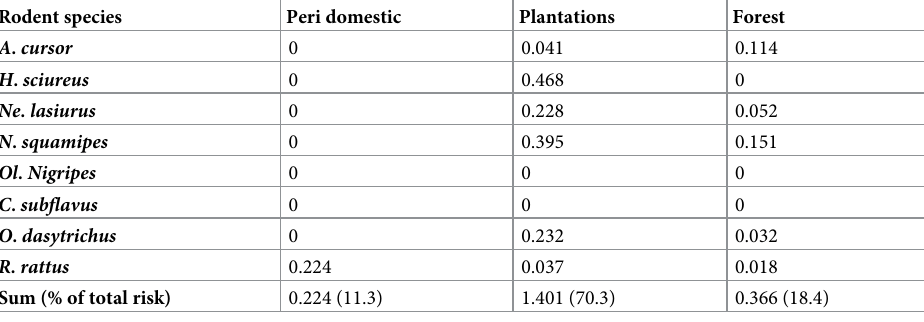
Table 5. Proportional risk 1 of infection in rodent species in sampled habitats. Rodent